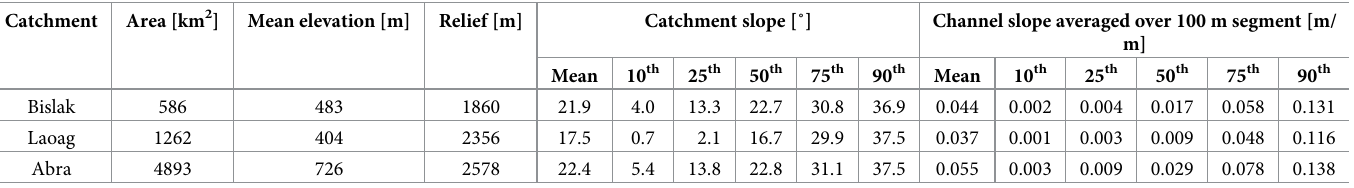
Table 3. Topographic attributes of the three catchments in NW